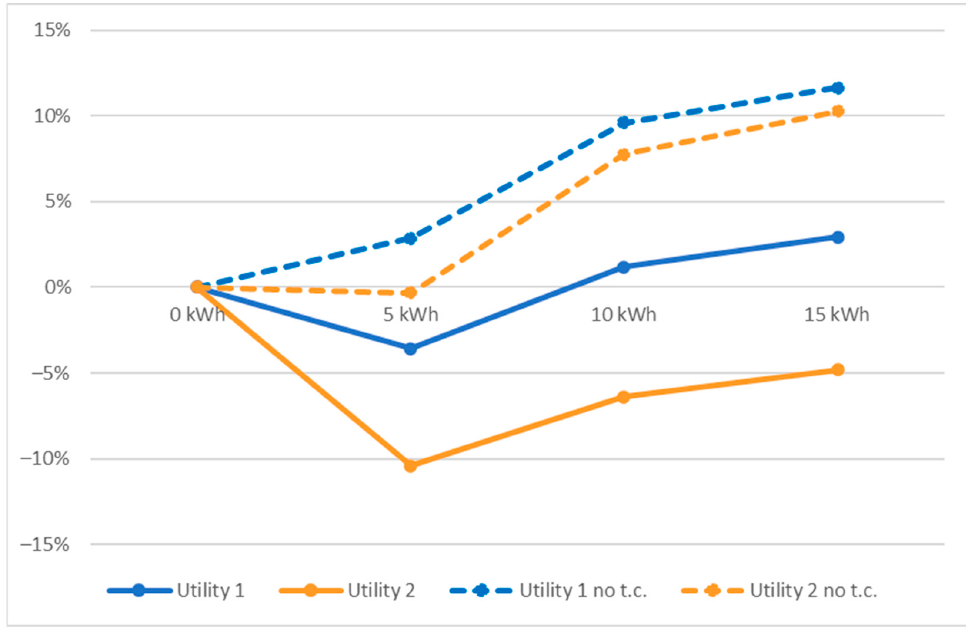
Figure 13. Annual net savings with and without doubled demand charges, compared to GRID-PV- ONLY.